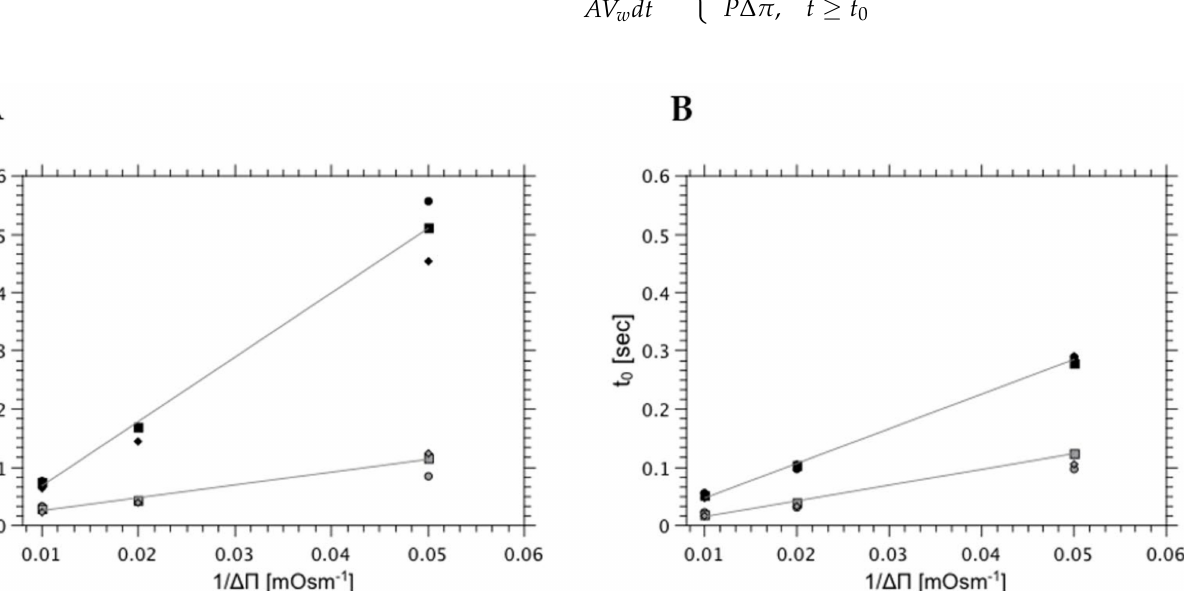
Figure 2. The change of the delay time as a function of 1/ ∆ π measured with different osmotically active compound (KCl (cid:4) (- • -), NaCl (- (cid:4) -) or sucrose (- -)) at two different temperatures (15 ◦ C—black symbols, 40 ◦ C—open symbols) determined for ( A ) egg-PC and ( B ) egg-PC/lysoPC (85:15)